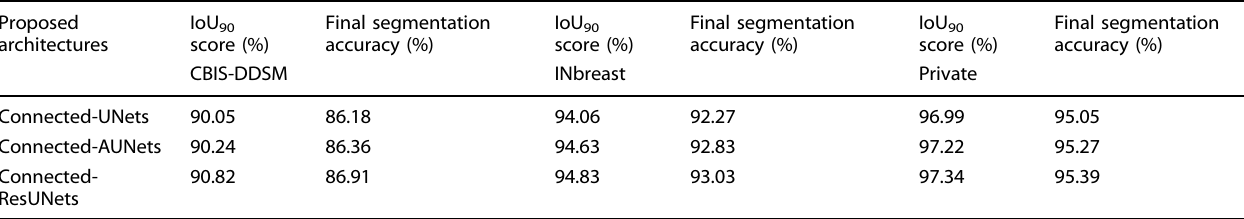
Table 4. Final segmentation performance of our proposed networks on the test sets.